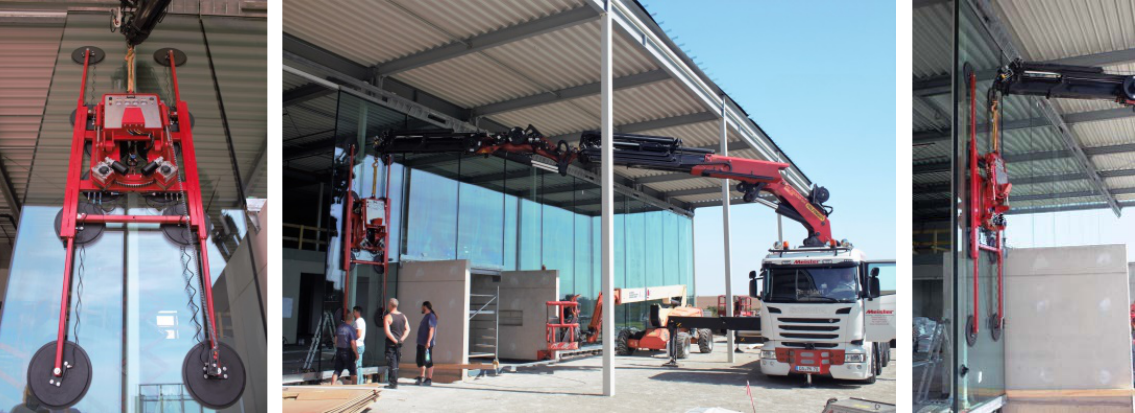
Fig. 7 Installation of the insulating glazing in the substructure of the façade prepared by the